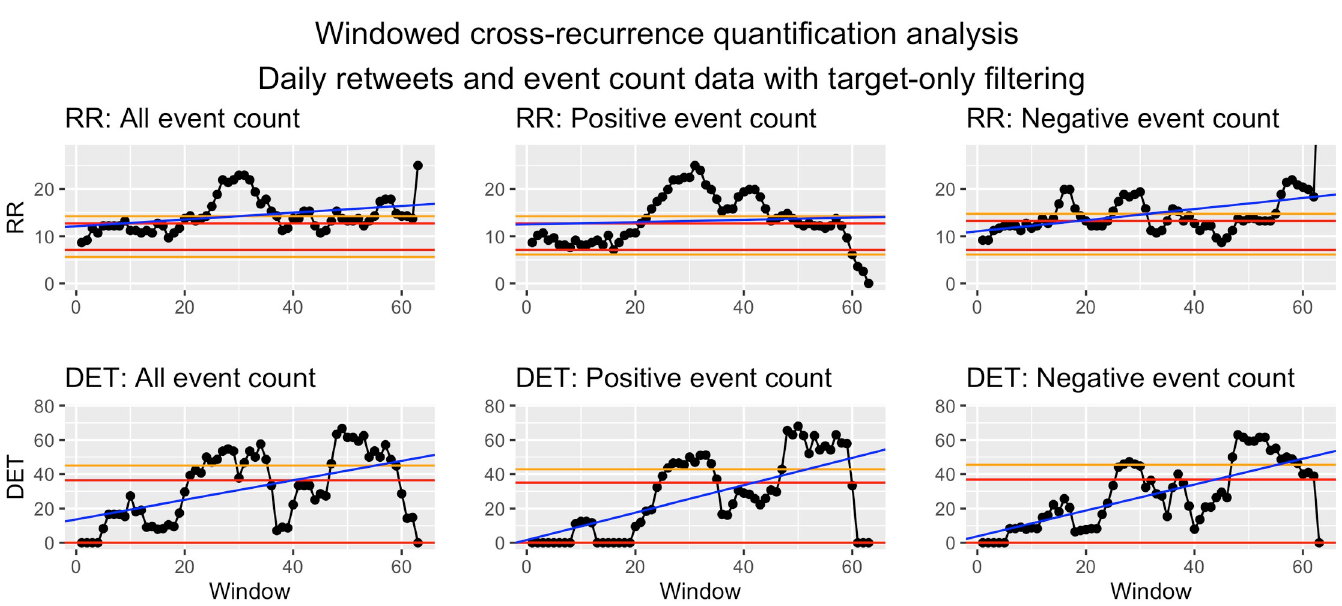
Fig 15. Windowed CRQA for daily retweets and event counts from target filtered